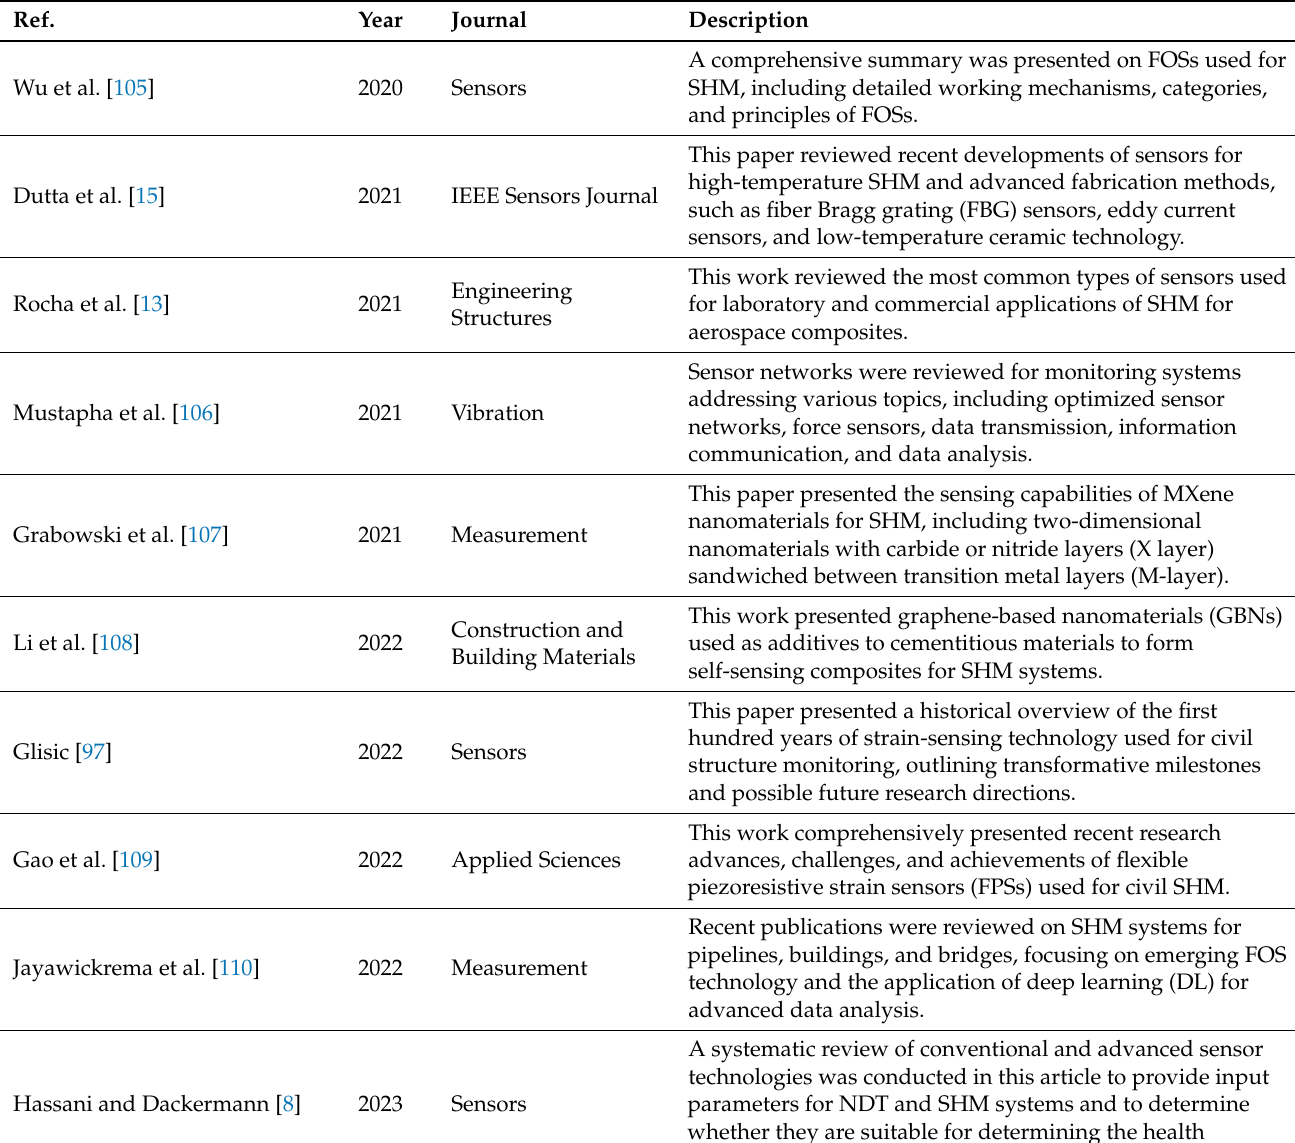
Table 8. Recent review papers on sensor systems for